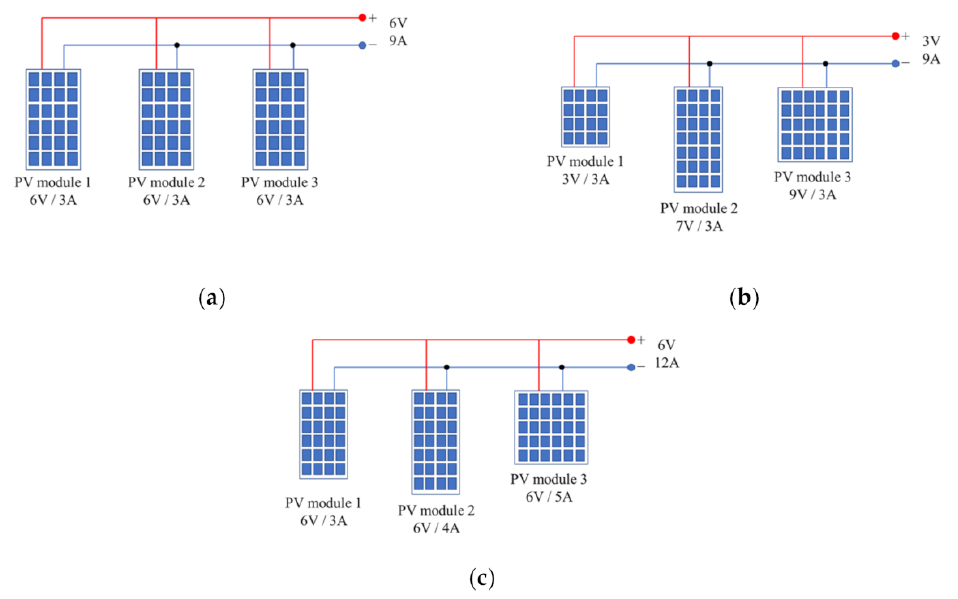
Figure 2. Electrical characteristics for parallel connection of PV modules: ( a ) PV modules in parallel with the same characteristics; ( b ) PV modules in parallel with different characteristics (i.e., voltage); ( c ) PV modules in parallel with different characteristics (i.e.,